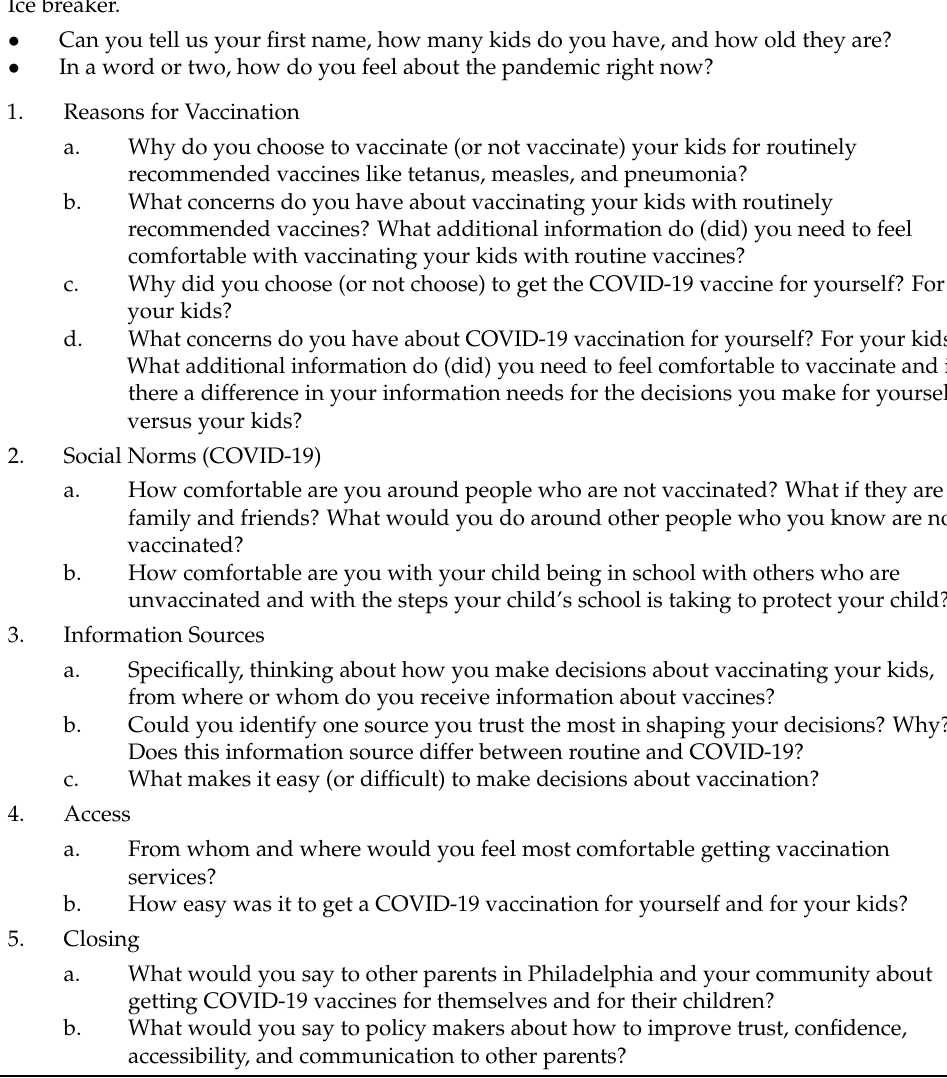
Table 1. Focus group question